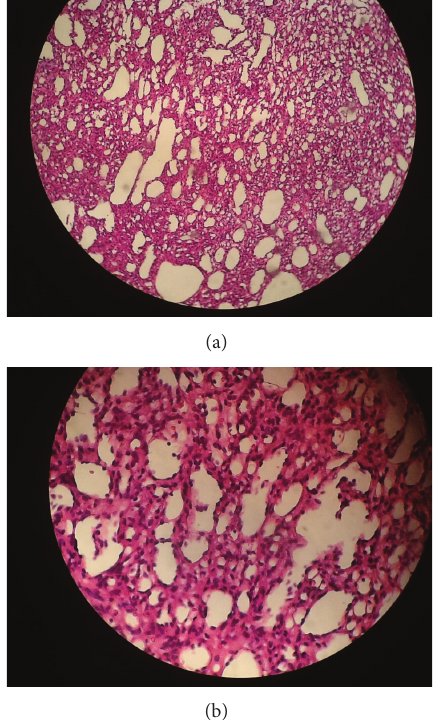
Figure 4: (a) and (b) showed vascular lesion containing small vessels of capillary caliber; closely packed spindle cells are also seen with neoformed spaces that contain little